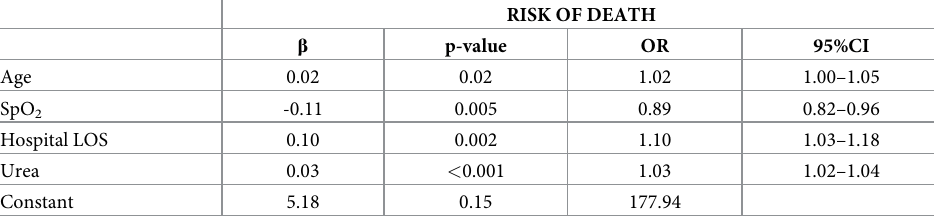
Table 2. Logistic regression of variables associated with death.